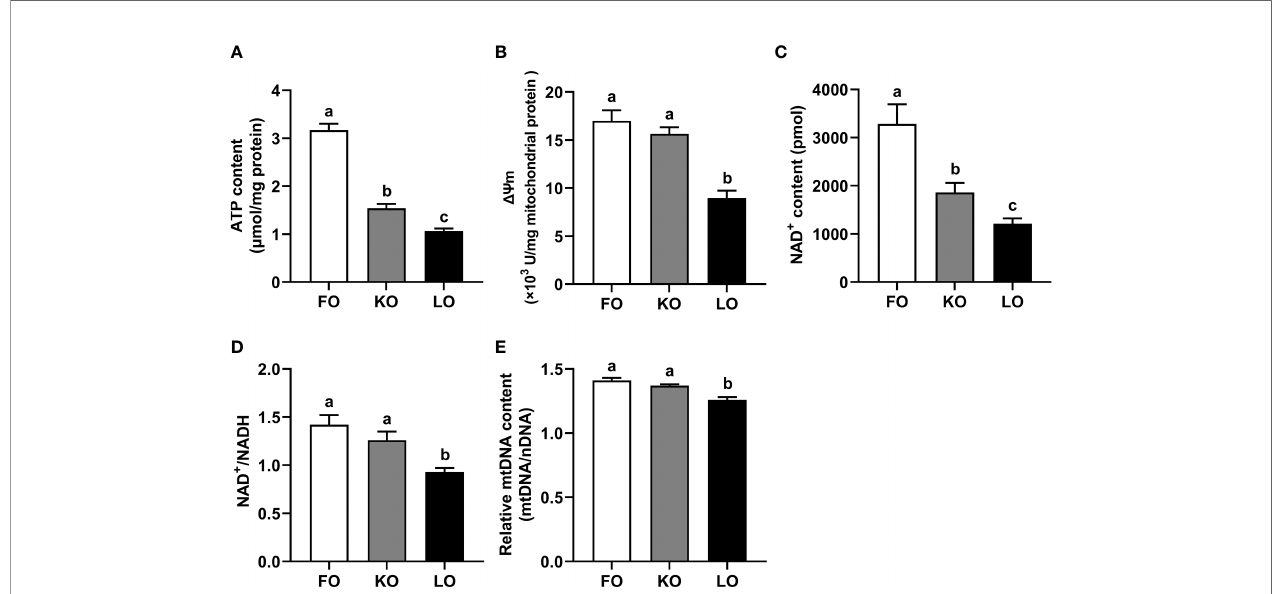
FIGURE 4 | Effects of different dietary lipid sources on the mitochondrial metabolic adaptation of swimming crab. Values are mean ± SE (n = 4). Bars with different superscripts represent signi fi cant difference by one-factor ANOVA followed by a Tukey ’ s multiple range post-hoc test (P < 0.05). (A) ATP, adenosine triphosphate; (B) DY m, mitochondrial membrane potential; (C) NAD+, nicotinamide adenine dinucleotide; (D) NAD+/NADH, the ratio of NAD+ (nicotinamide adenine dinucleotide) and NADH (reduced nicotinamide adenine dinucleotide); (E) Relative mtDNA content, relative mtDNA copy number